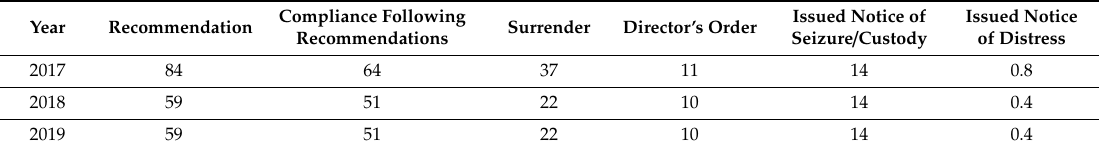
Table 7. Chief Veterinary O ffi ce Inspection Outcomes where Non-Compliance is Identified, 2017–2019